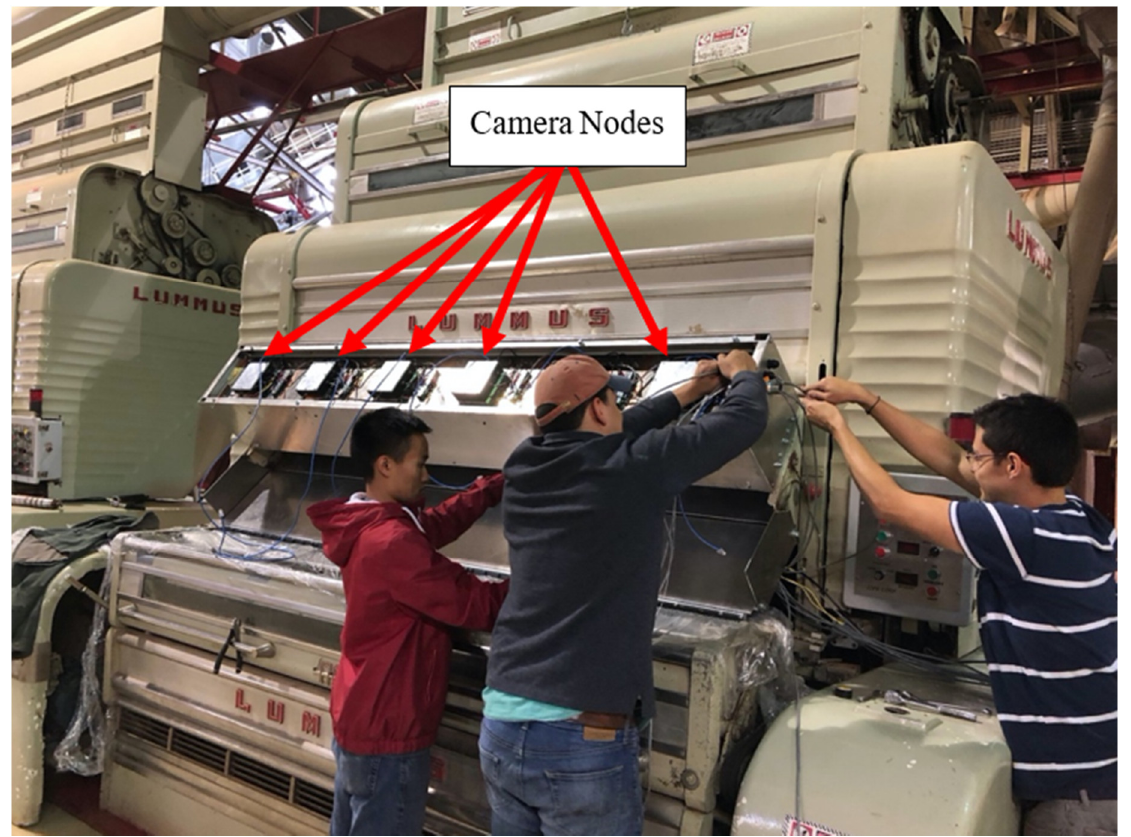
Figure 4. Gin-stand feeder-apron installation with a bank of 6 camera-computer nodes.